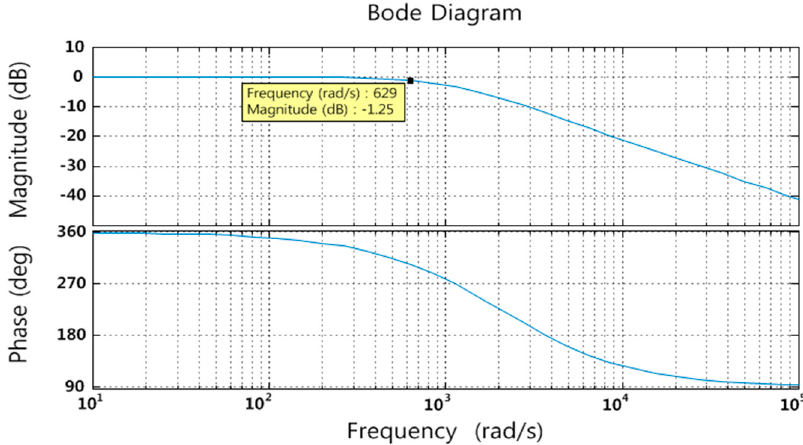
Figure 8. Bode diagram of a voltage controller closed-loop transfer function.